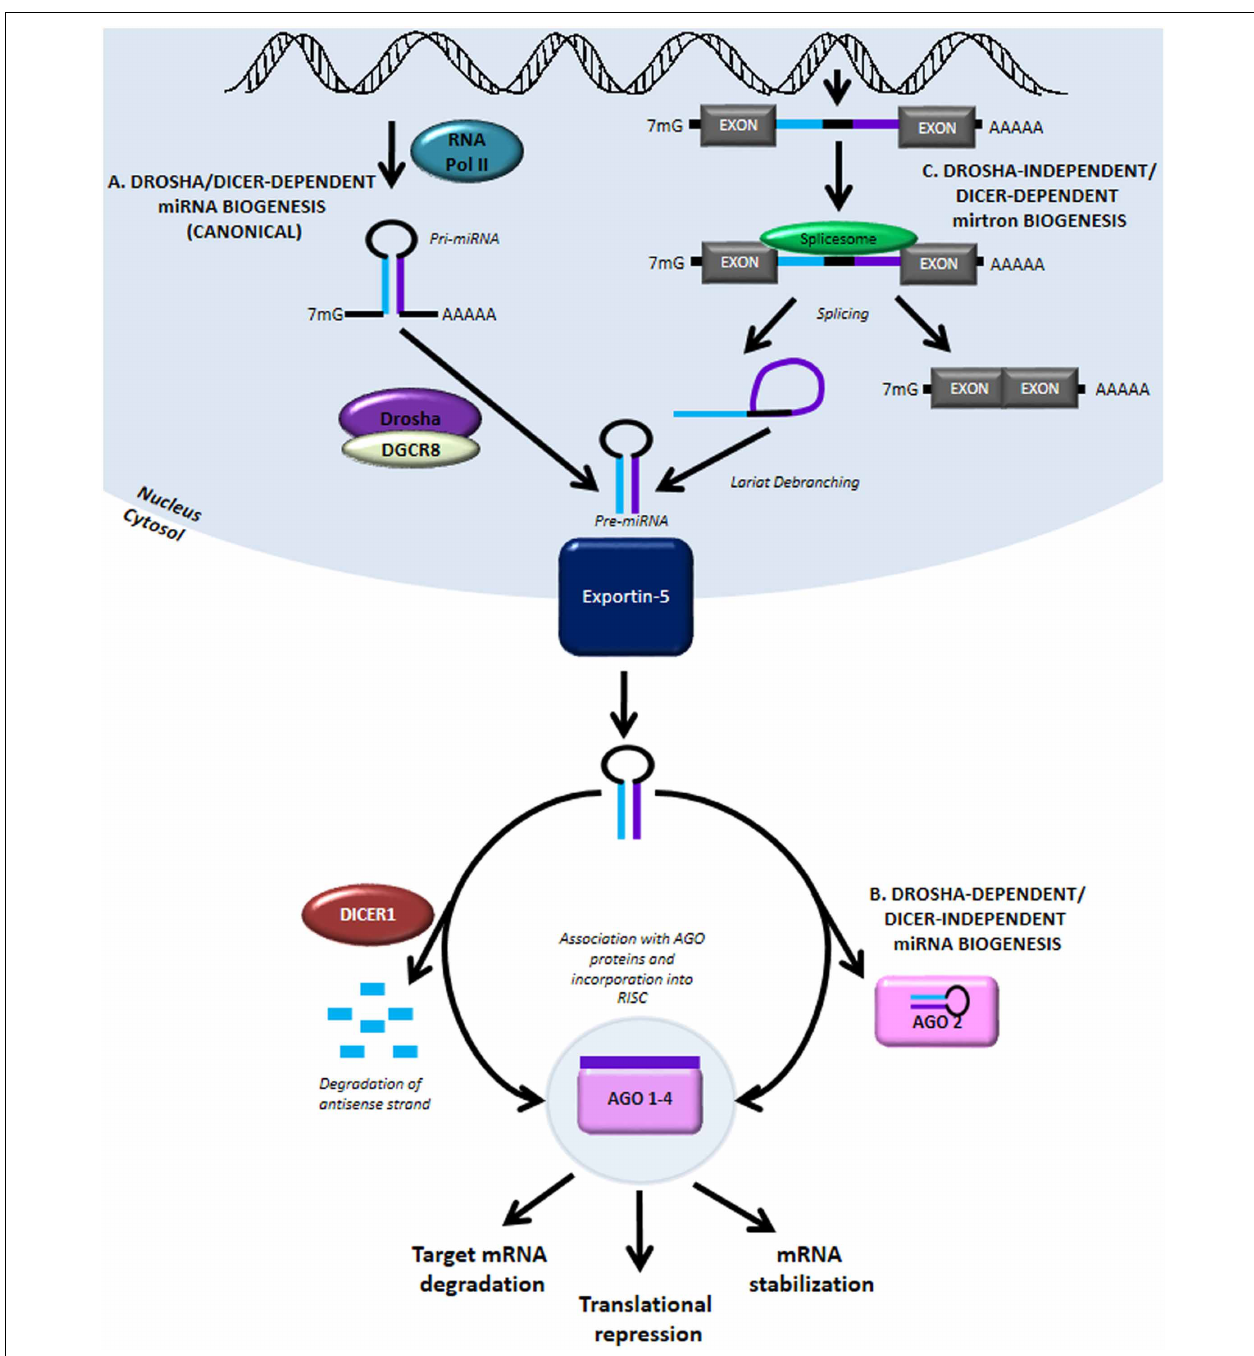
FIGURE 1 | MiRNA biogenesis and function. (A) The canonical miRNA biogenesis pathway is Drosha- and Dicer-dependent. It begins with RNA Pol II-mediated transcription of genomic loci containing miRNA genes. The primary transcript is referred to as pri-miRNA and like other RNA Pol II transcripts contains a 5 (cid:3) 7-methylgunaosine cap and 3 (cid:3) poly-A tail. The pri-miRNA is processed in the nucleus by Drosha and DGCR8 to form pre-miRNA. The pre-miRNA is then exported into the cytoplasm by Exportin-5 where it is further processed by the RNase III enzyme, Dicer. Interaction with Dicer leads to hairpin cleavage and degradation of the anti-sense strand of the miRNA duplex, while the mature guide strand is complexed with members of